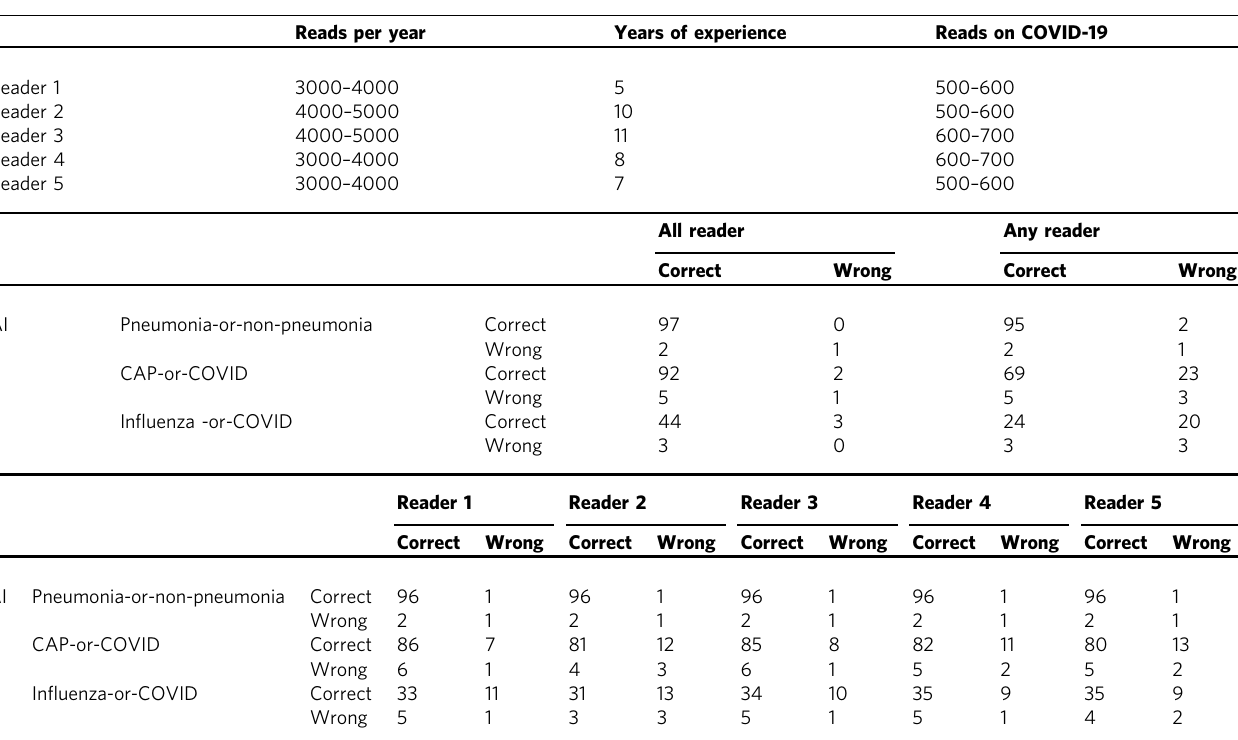
Table 3 Reader study statistics and